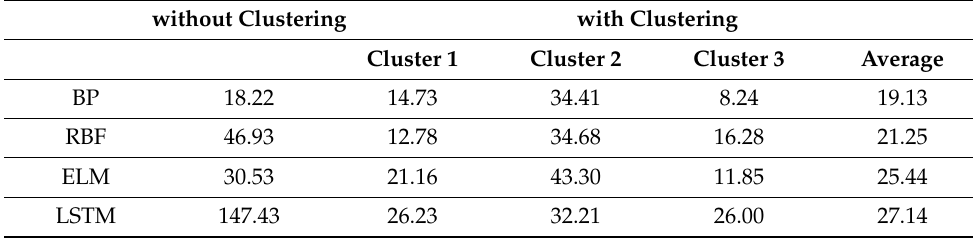
Table 8. MAE of solar radiation forecast errors in